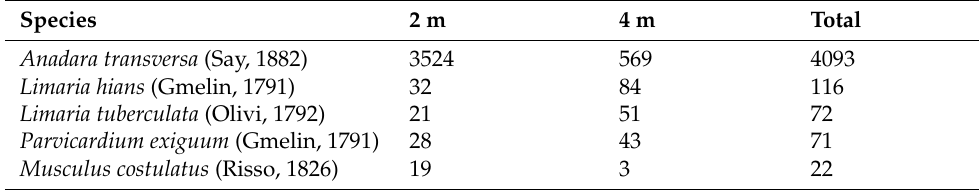
Table 3. The most abundant bivalve species on larval collectors in Pisak Cove in 2020.